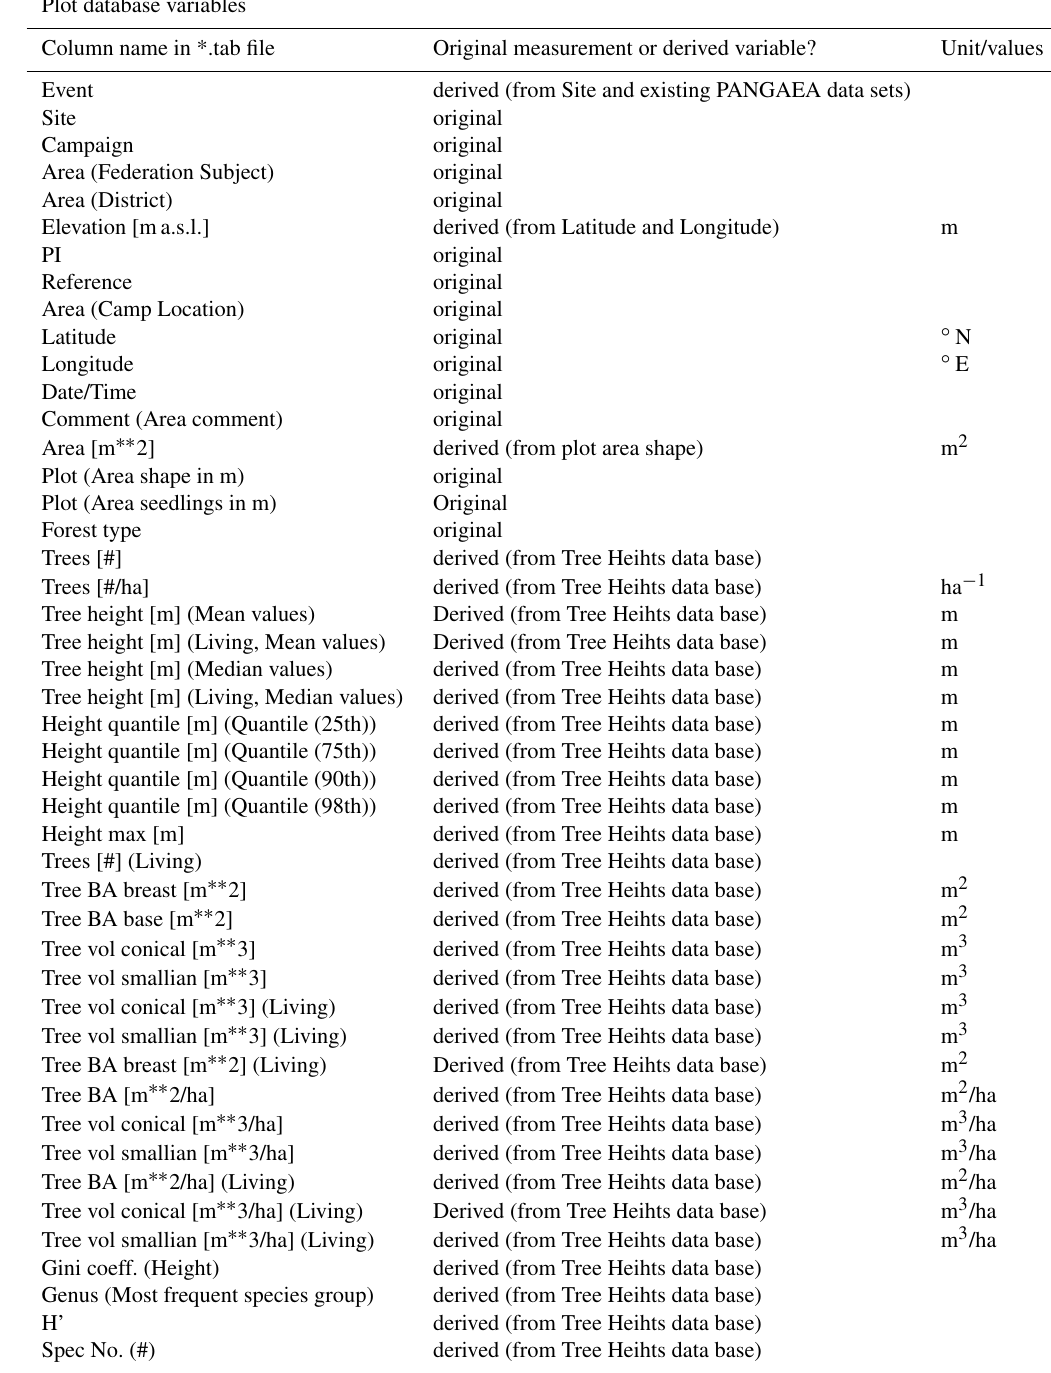
Table B2. List of all variables of the plot database. The spelling, capitalization, grammar and units reflect the original database. Plot database